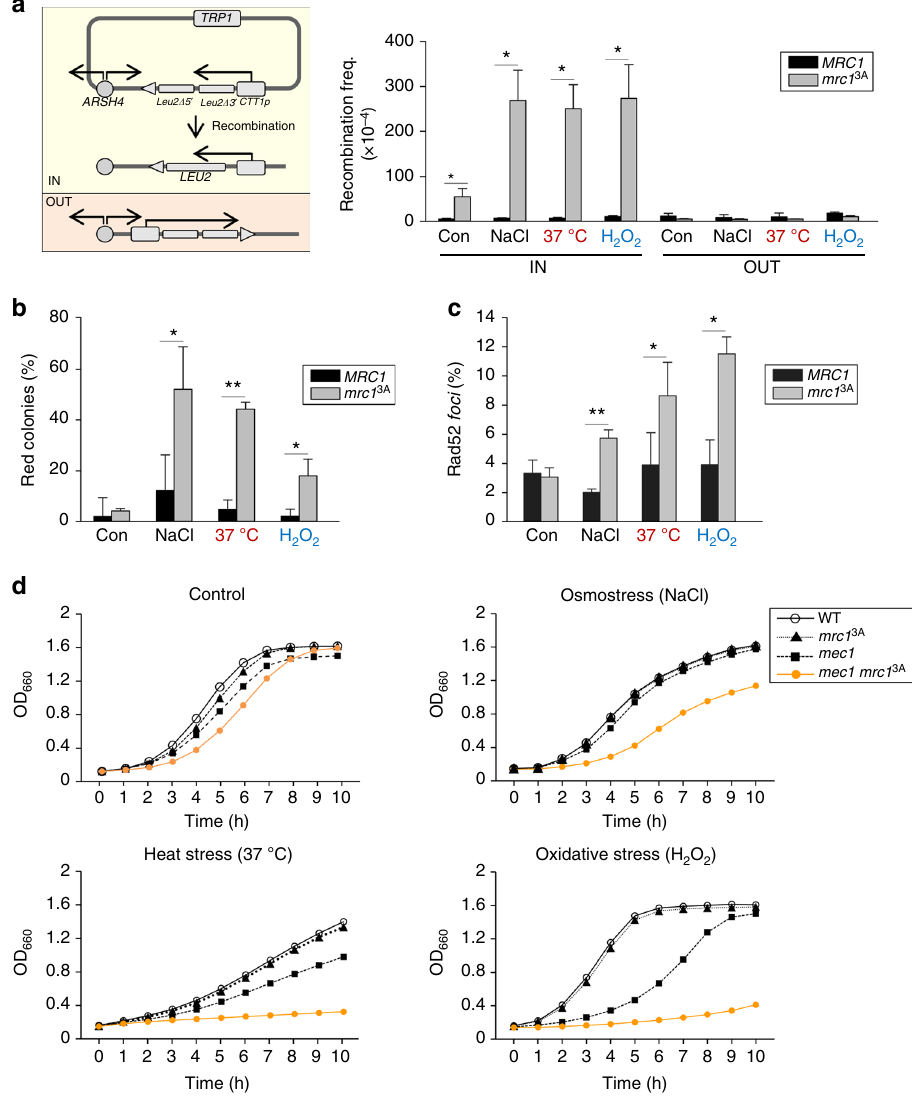
Fig. 2 Mrc1 phosphorylation prevents TAR and genomic instability. a Schematic diagram of the IN/OUT vectors used in the TAR assays. mrc1 3A cells display higher levels of recombination than wild-type cells in TAR assays upon release of synchronized cells from S-phase block into osmotic, heat stress, and oxidative stresses (see Methods). b mrc1 3A cells show higher frequency of plasmid loss upon release of synchronized cells from S-phase block into environmental stresses in a red-sectoring assay (see “ Methods ” section). c mrc1 3A cells display a higher percentage of Rad52-YFP foci upon release of synchronized cells from S-phase block into environmental stresses. Data in a , b , and c represent the mean and standard deviation of three independent experiments. Values that are signi fi cantly different (* p < 0.05, ** p < 0.01, *** p < 0.005) from Student's t test are annotated. d mrc1 3A cells show a synthetic cell growth defect with mec1 deletion upon stress. The indicated strains were grown to log phase and subjected to the indicated